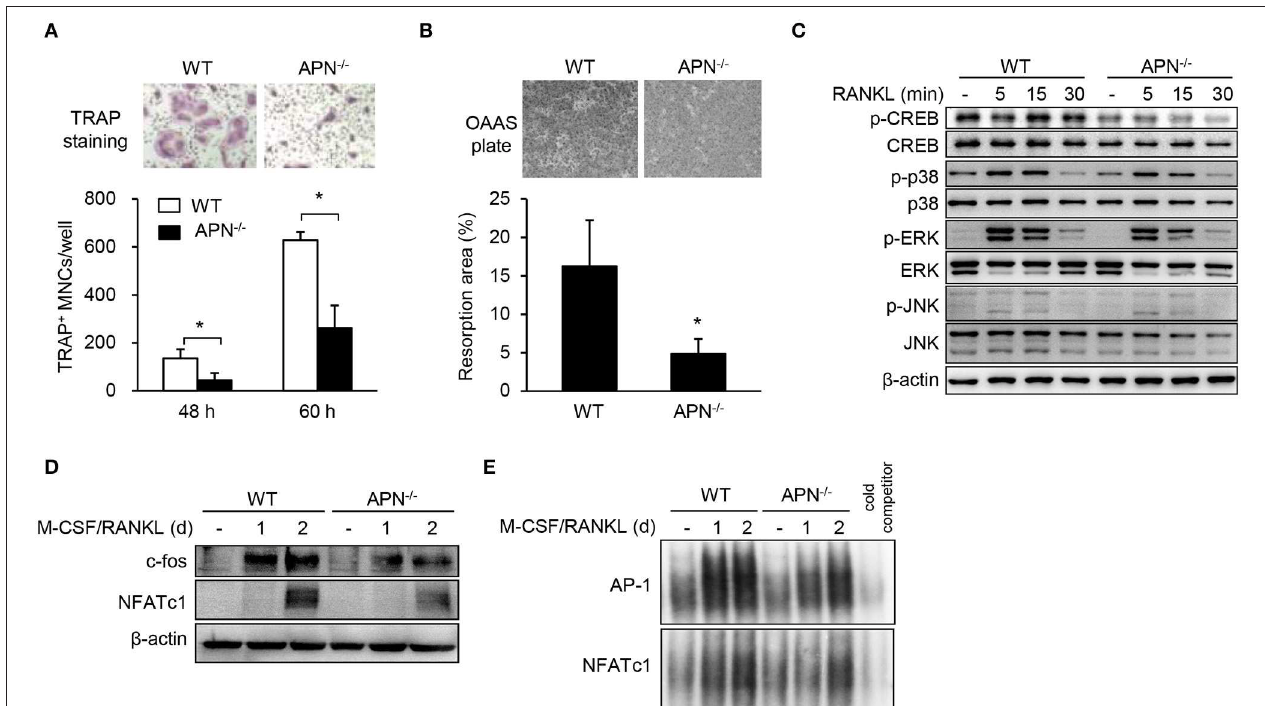
FIGURE 4 | Macrophages derived from adiponectin-deficient mice exhibit attenuated RANKL-induced osteoclast differentiation. (A) Stroma-free bone marrow cells were incubated with M-CSF (20ng/ml) for 5 days followed by treatment with M-CSF (20ng/ml) and RANKL (40ng/ml) for additional 48 or 60h. The cells were fixed and stained for TRAP. TRAP + MNCs were photographed (magnification, × 200) and enumerated. (B) BMMs seeded on calcium phosphate-coated plates were incubated with M-CSF (20ng/ml) and RANKL (40ng/ml) for 5 days. Resorbed pits were photographed (magnification, × 40) and total resorption area per well was measured with ImageJ software. (C) BMMs were serum-starved for 3h and stimulated with RANKL (100ng/ml) for 0, 5, 15, or 30min. Then, the cells were lysed and subjected to immunoblots for the detection of phosphorylated and non-phosphorylated forms of CREB, p38, ERK, and JNK. (D) BMMs were incubated with M-CSF (20ng/ml) and RANKL (100ng/ml) for 1 or 2 days. Immunoblots were performed with antibodies specific to c-Fos and NFATc1. (E) BMMs were incubated with M-CSF (20ng/ml) and RANKL (100ng/ml) for 1 or 2 days. Nuclear extracts were incubated with 32 P-labeled NFATc1 and AP-1 binding site-oligonucleotides. Protein-DNA binding complexes were electrophoresed and performed autoradiography. Unlabeled probe was used as a control and marked as “cold competitor.” Data are mean values ± SD of triplicate samples and are representative of three similar independent experiments. * P <